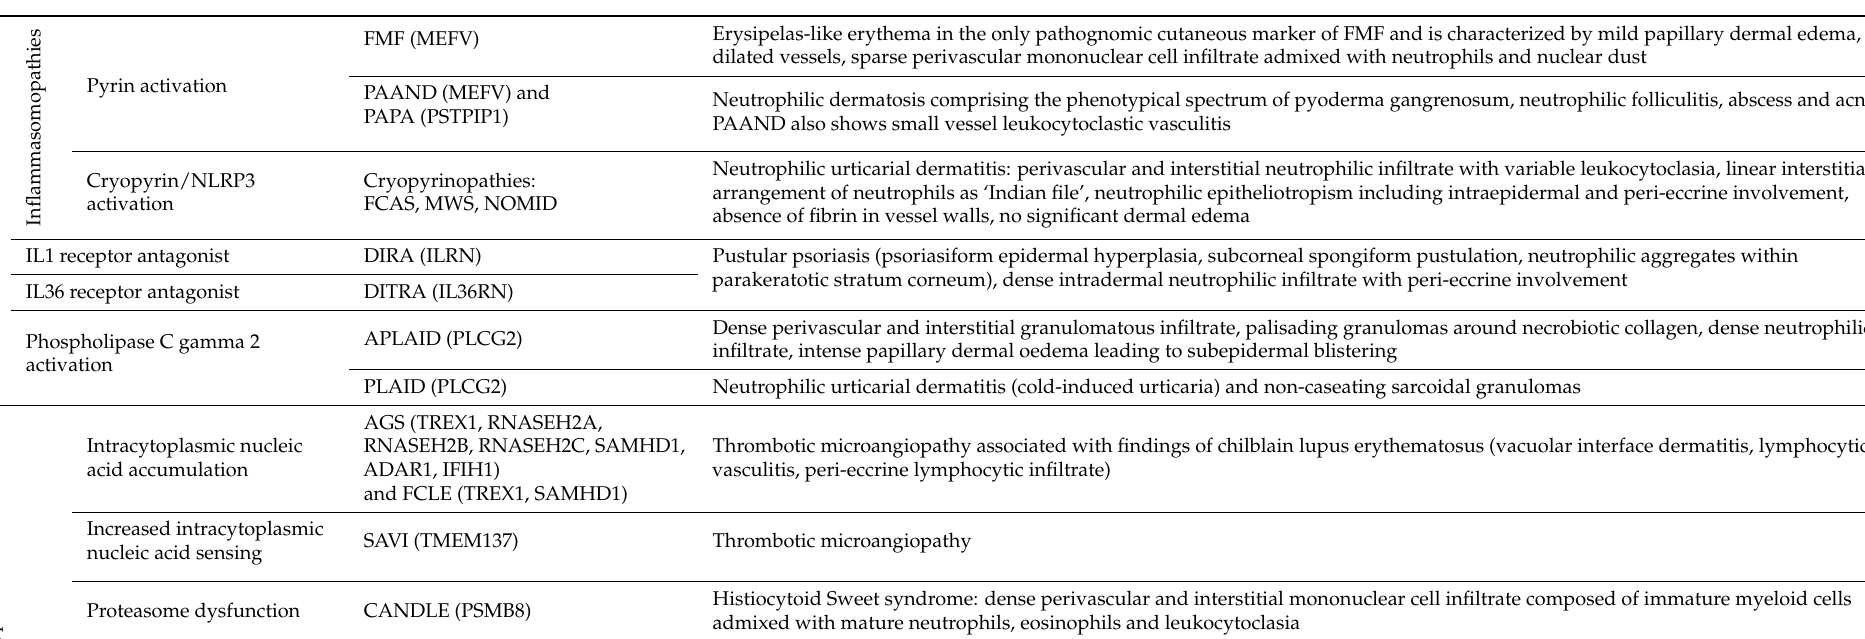
Table 1. Main histopathological findings for the major monogenic autoinflammatory syndromes with their mechanism of pathogenesis and identified mutated genes (in parenthesis): AGS, Aicardi Gouti è res Syndrome; APLAID, autoinflammation and phospholipase C gamma 2 associated antibody deficiency and immune dysregulation; CANDLE, Chronic atypical neutrophilic dermatosis with lipodystrophy and elevated temperature; CAPE, caspase-activating recruitment domain member 14 associated papulosquamous eruption, DADA2, deficiency of adenosine deaminase 2; DIRA, Deficiency of IL-1 receptor antagonist syndrome; DITRA, Deficiency of IL-36 receptor antagonist; FCAS, Familial cold autoinflammatory syndrome; FCLE, Familial chilblain lupus erythematosus; FMF, Familial Mediterranean fever syndrome; HA20, Haploinsufficiency of A20; MWS, Muckle–Wells syndrome; NAID, NOD-2 associated autoinflammatory syndrome; NOMID, Neonatal-onset multisystem inflammatory disease; PAAND, pyrin-associated autoinflammation with neutrophilic dermatosis; PAPA, Pyogenic Arthritis, pyoderma gangrenosum and acne; PLAID, Phospholipase C gamma 2 associated antibody deficiency and immune dysregulation; SAVI, Stimulator of interferon genes (STING) associated vasculopathy of infancy; TRAPS, TNF receptor-associated periodic